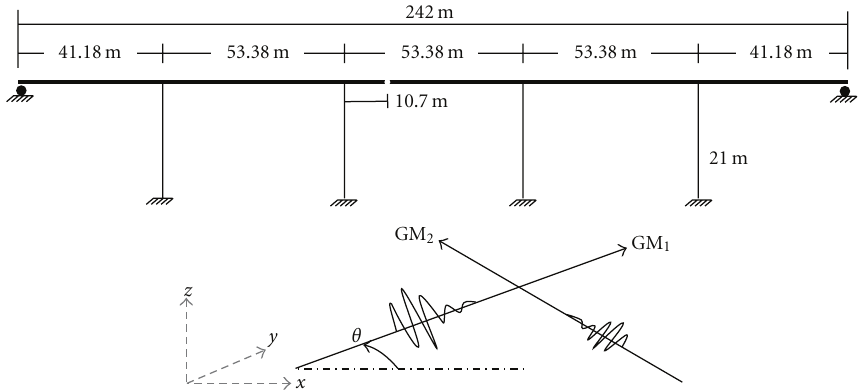
Figure 2: Example bridge under two horizontal orthogonal components of earthquake ground motions.